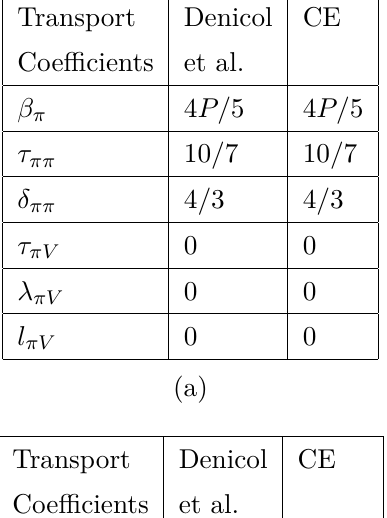
JHEP03(2021)216